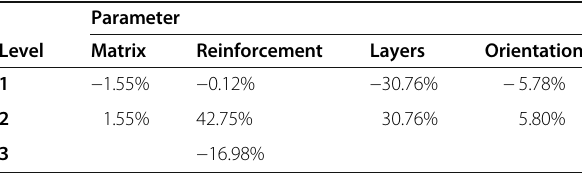
Table 8 The differential mean E values (as a % of the global average E - dotted line on Fig.